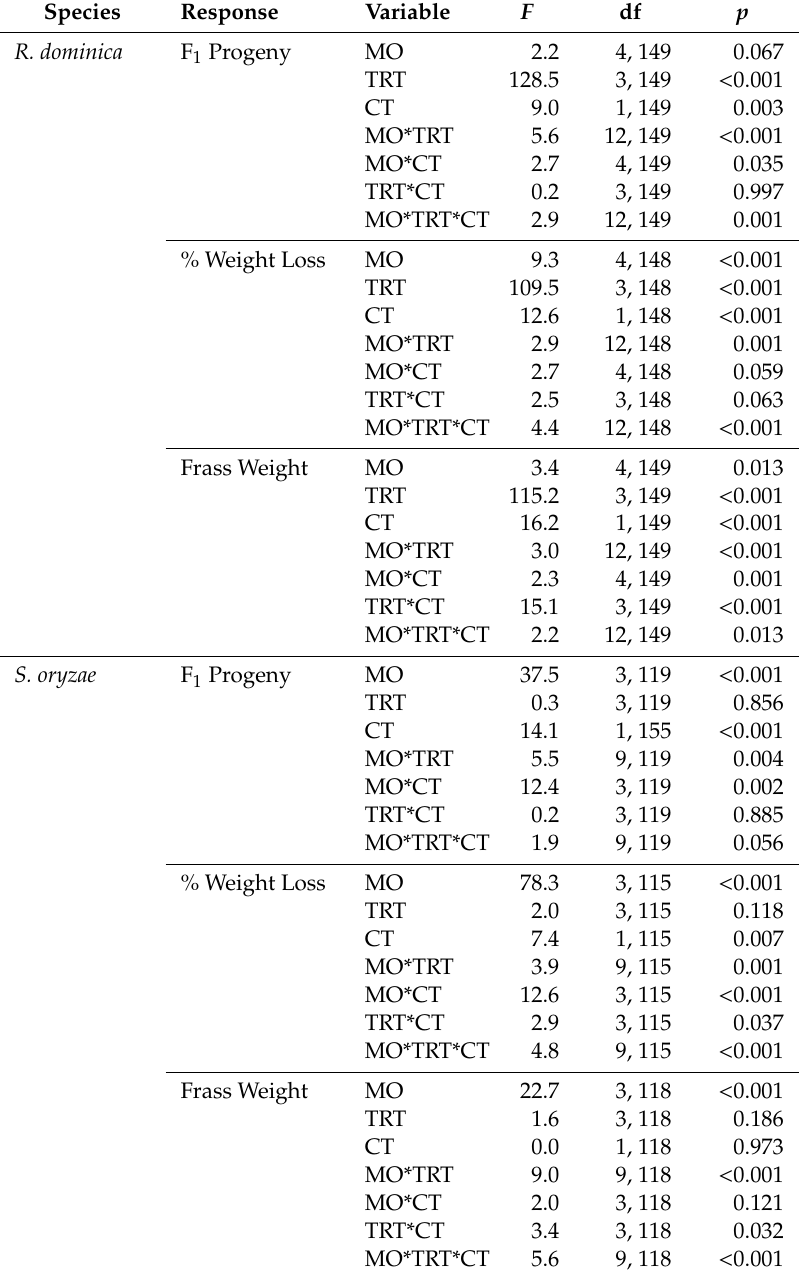
Table 13. ANOVA Table for main e ff ects month (MO), treatment (untreated controls, two rates of Diacon IGR + , and the Gravista formulation), and count (CT, parental insects removed after 7 days or left continuously on the corn for 8 weeks), and all associated interactions, for R. dominica and S. oryzae F 1 progeny, % of sample weight loss, and weight in grams of feeding damage 1